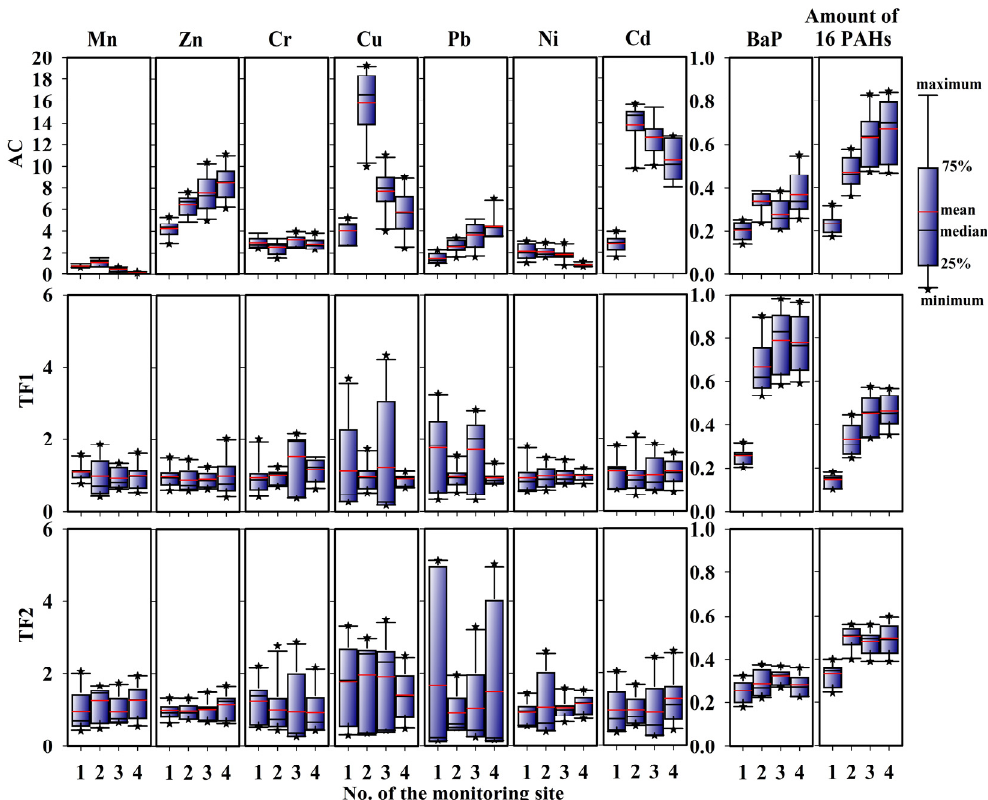
Figure 5. Accumulation coefficient (AC), translocation coefficients of pollutants between at the root-stem (TF1), and stem–grain (TF2) boundary of various pollutants in wheat ( Triticum aestivum ) over a 10-year monitoring period. *—outlier.